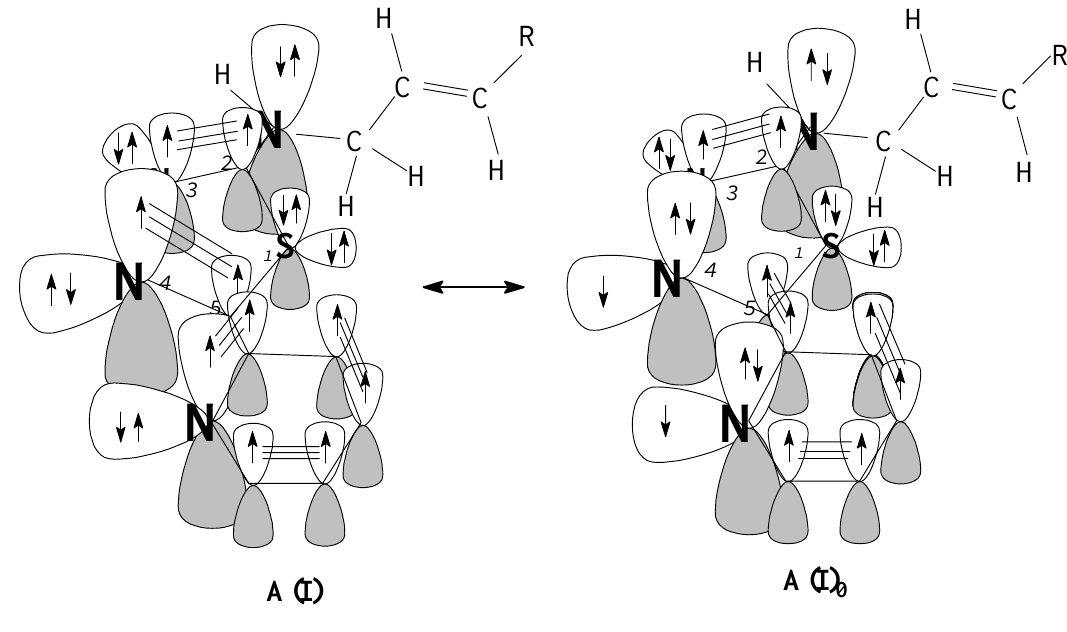
of allyl-( 1 ) and 0